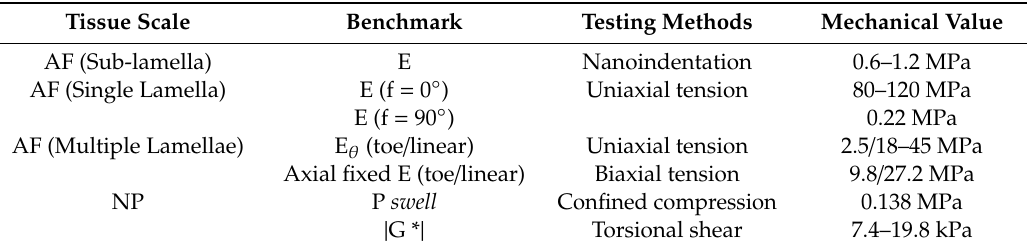
Table 3. Summary of the mechanical properties of native AF and NP tissue.